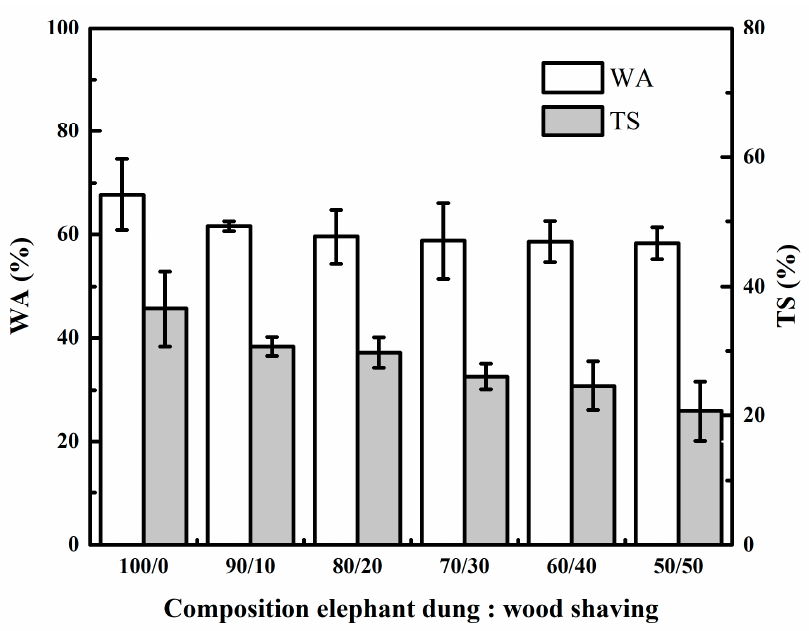
Figure 4. Effect of wood shaving on WA and TS of elephant dung particleboard.